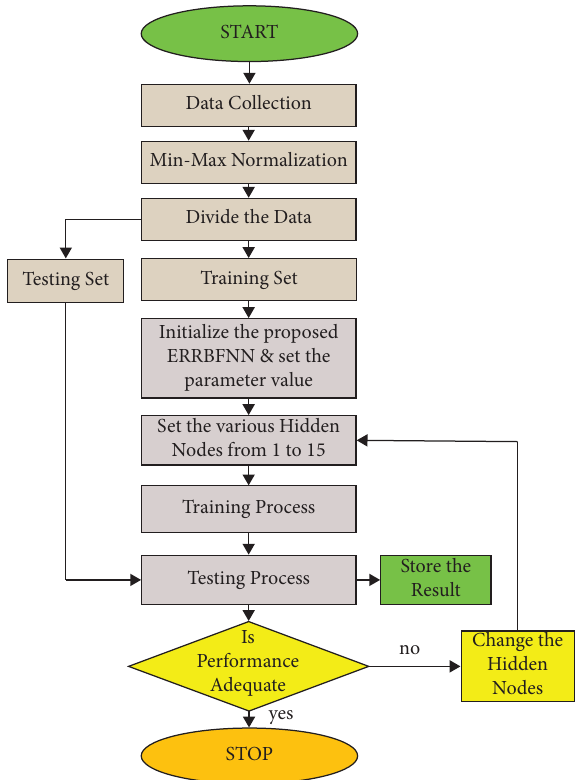
Figure 3: Proposed ERRBFNN